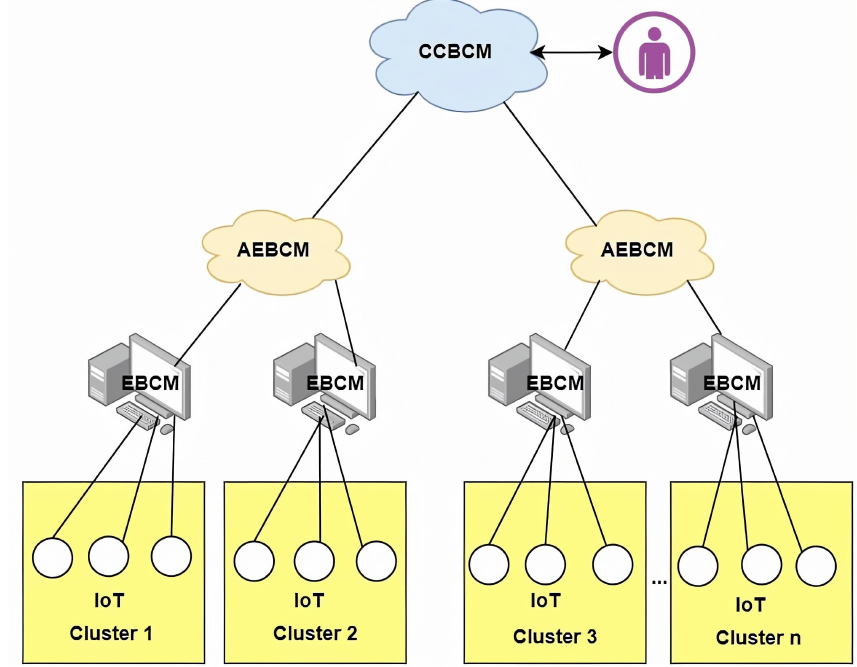
Figure 2. Deployment architecture for layered hierarchical BC